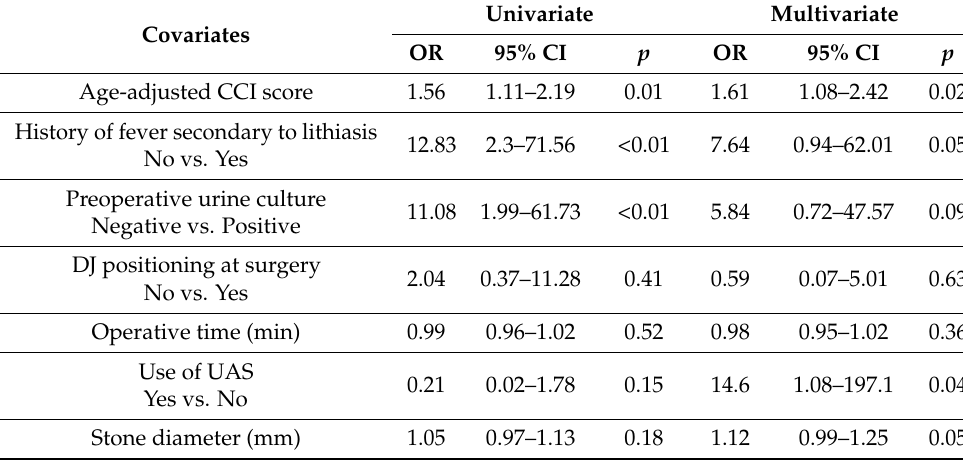
Table 5. Univariable and multivariable logistic regression analyses predicting postoperative septic